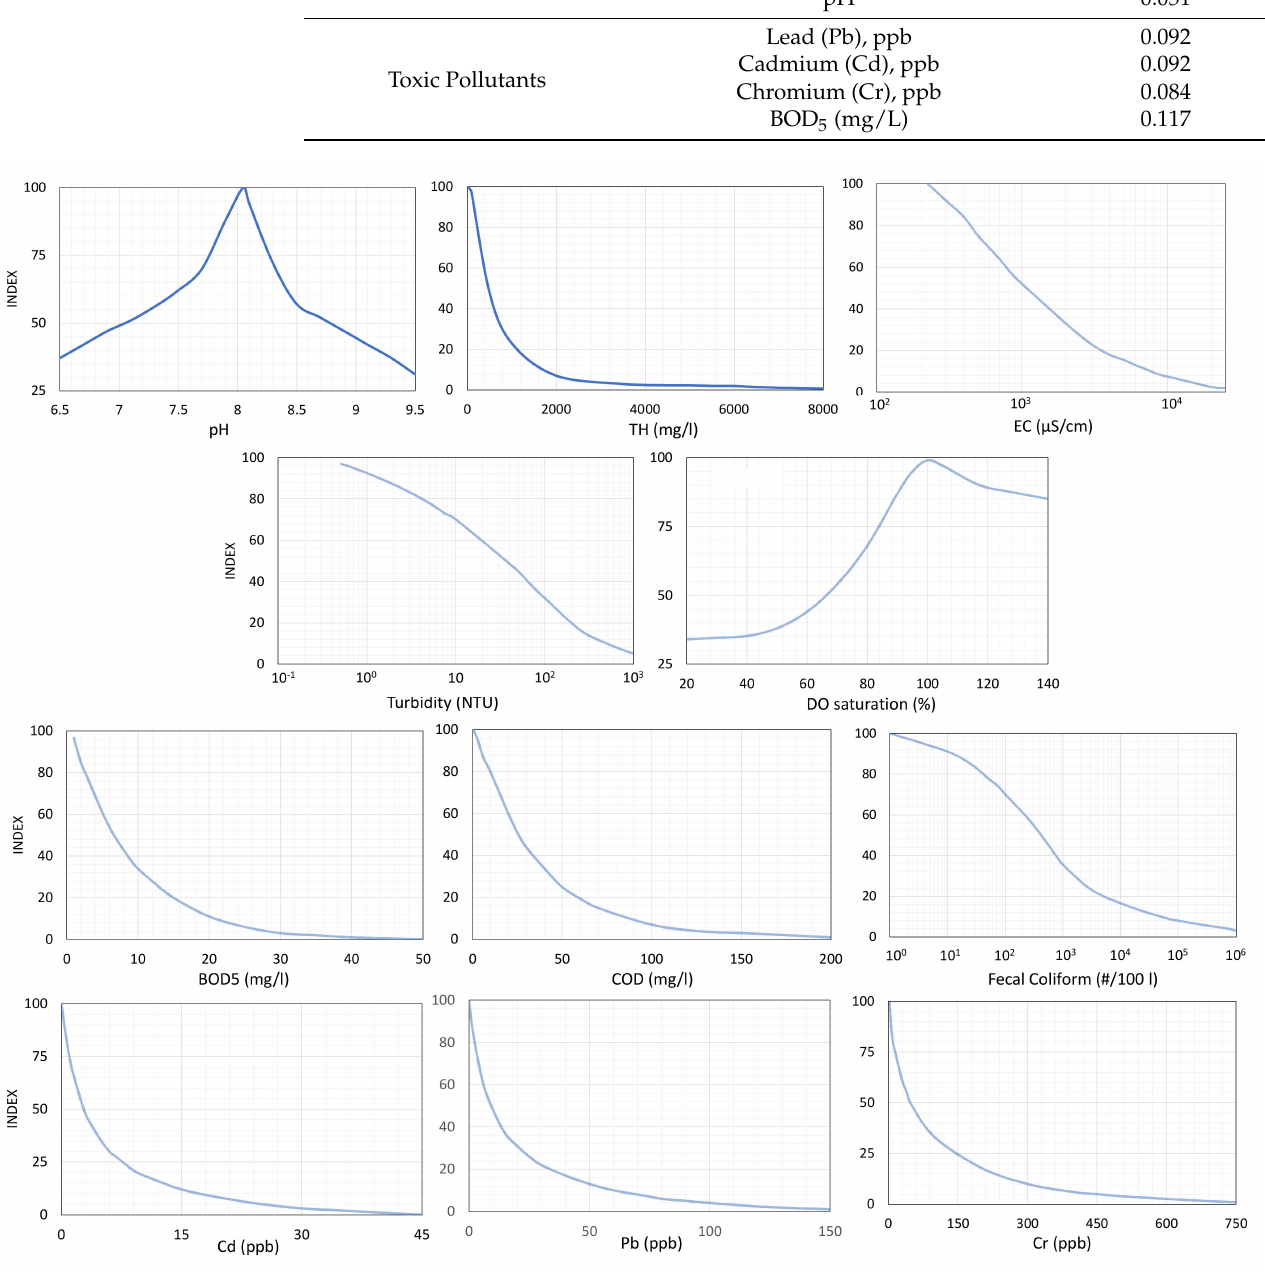
Figure 1. Evolution of sub-index values, I i , with the value of i -th water quality parameter observed in the RWH